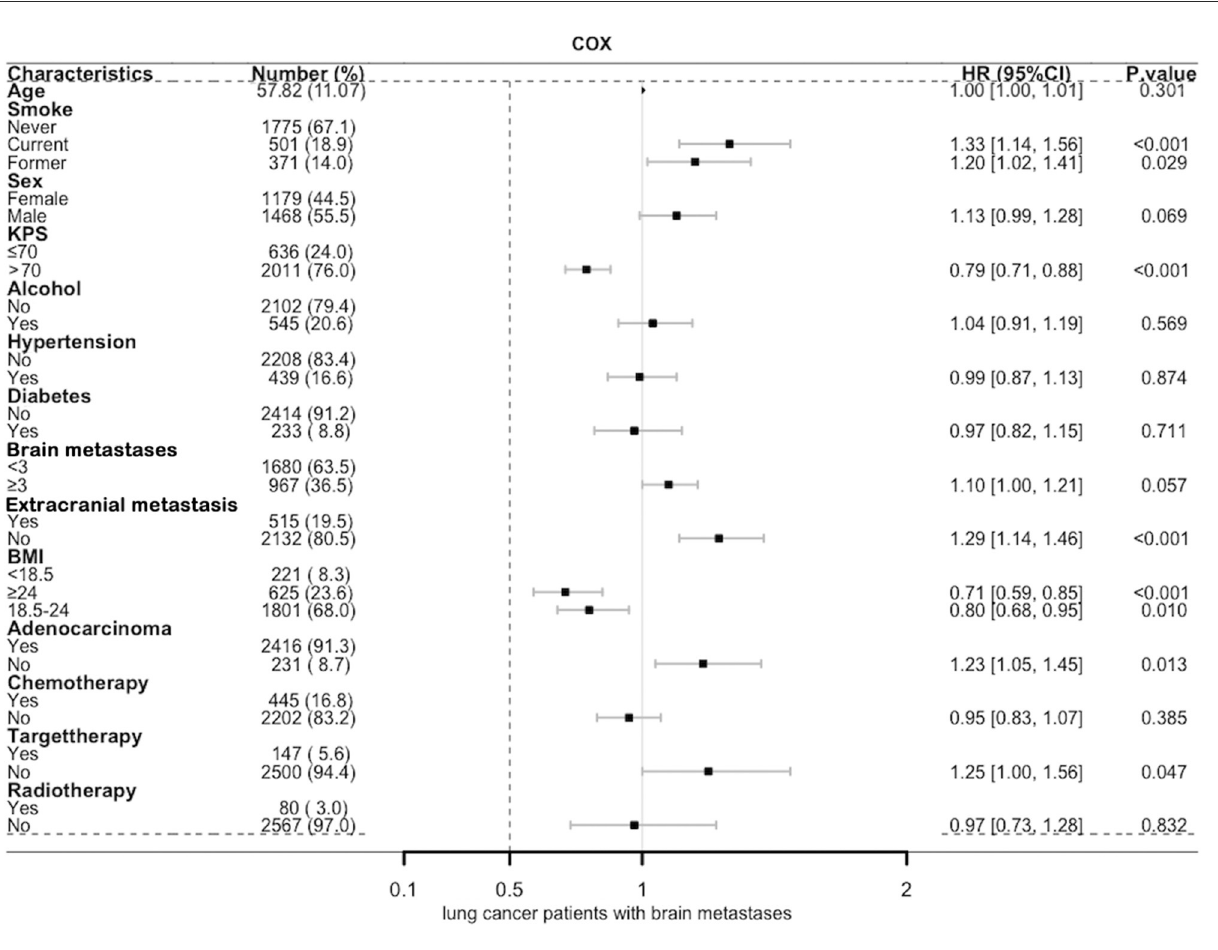
brain metastasis coded C34 and secondary invasive C79.3 were screened from the West China Hospital of Sichuan University database according to the 10th edition of the International Classification of Diseases for Oncology